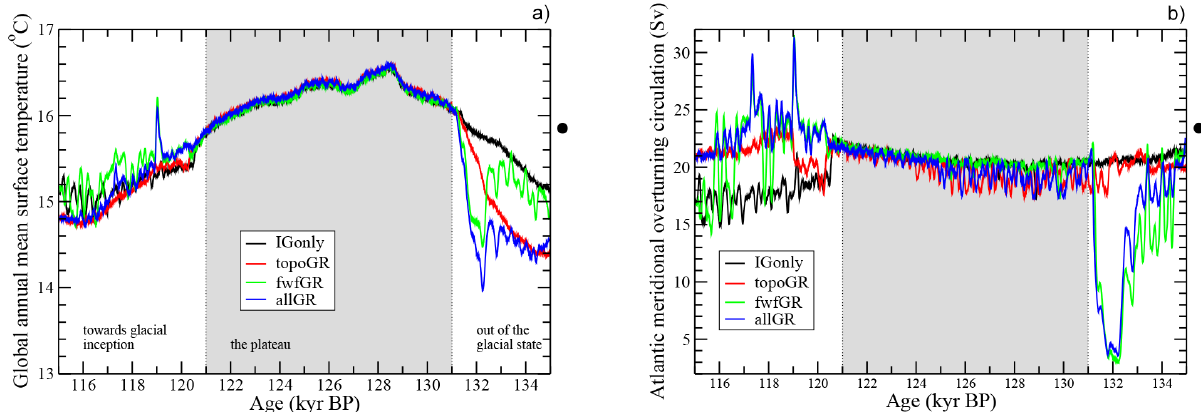
Figure 4. Time evolution of (a) (left) global annual mean surface temperature ( ◦ C); (b) (right) maximum of the meridional overturning stream function in the North Atlantic from model simulations using different surface boundary conditions (see text and Table 1). The series are smoothed using a moving average over 100yr. The black dot on the right hand side of the figures provides the corresponding simulated pre-industrial